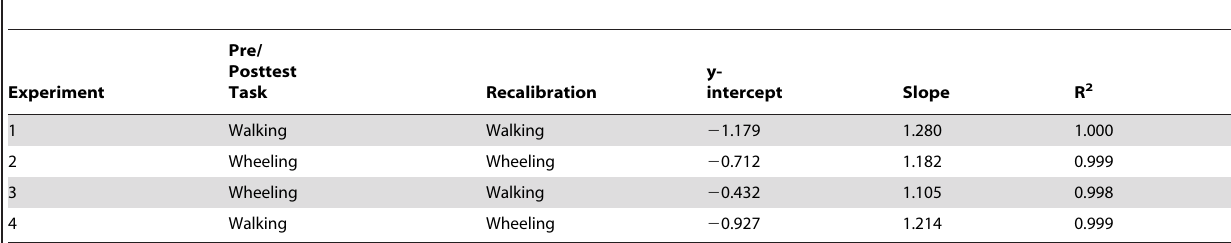
Table 1. Slope, intercept and R 2 for linear fit through the mean values walked or wheeled for each target distance.